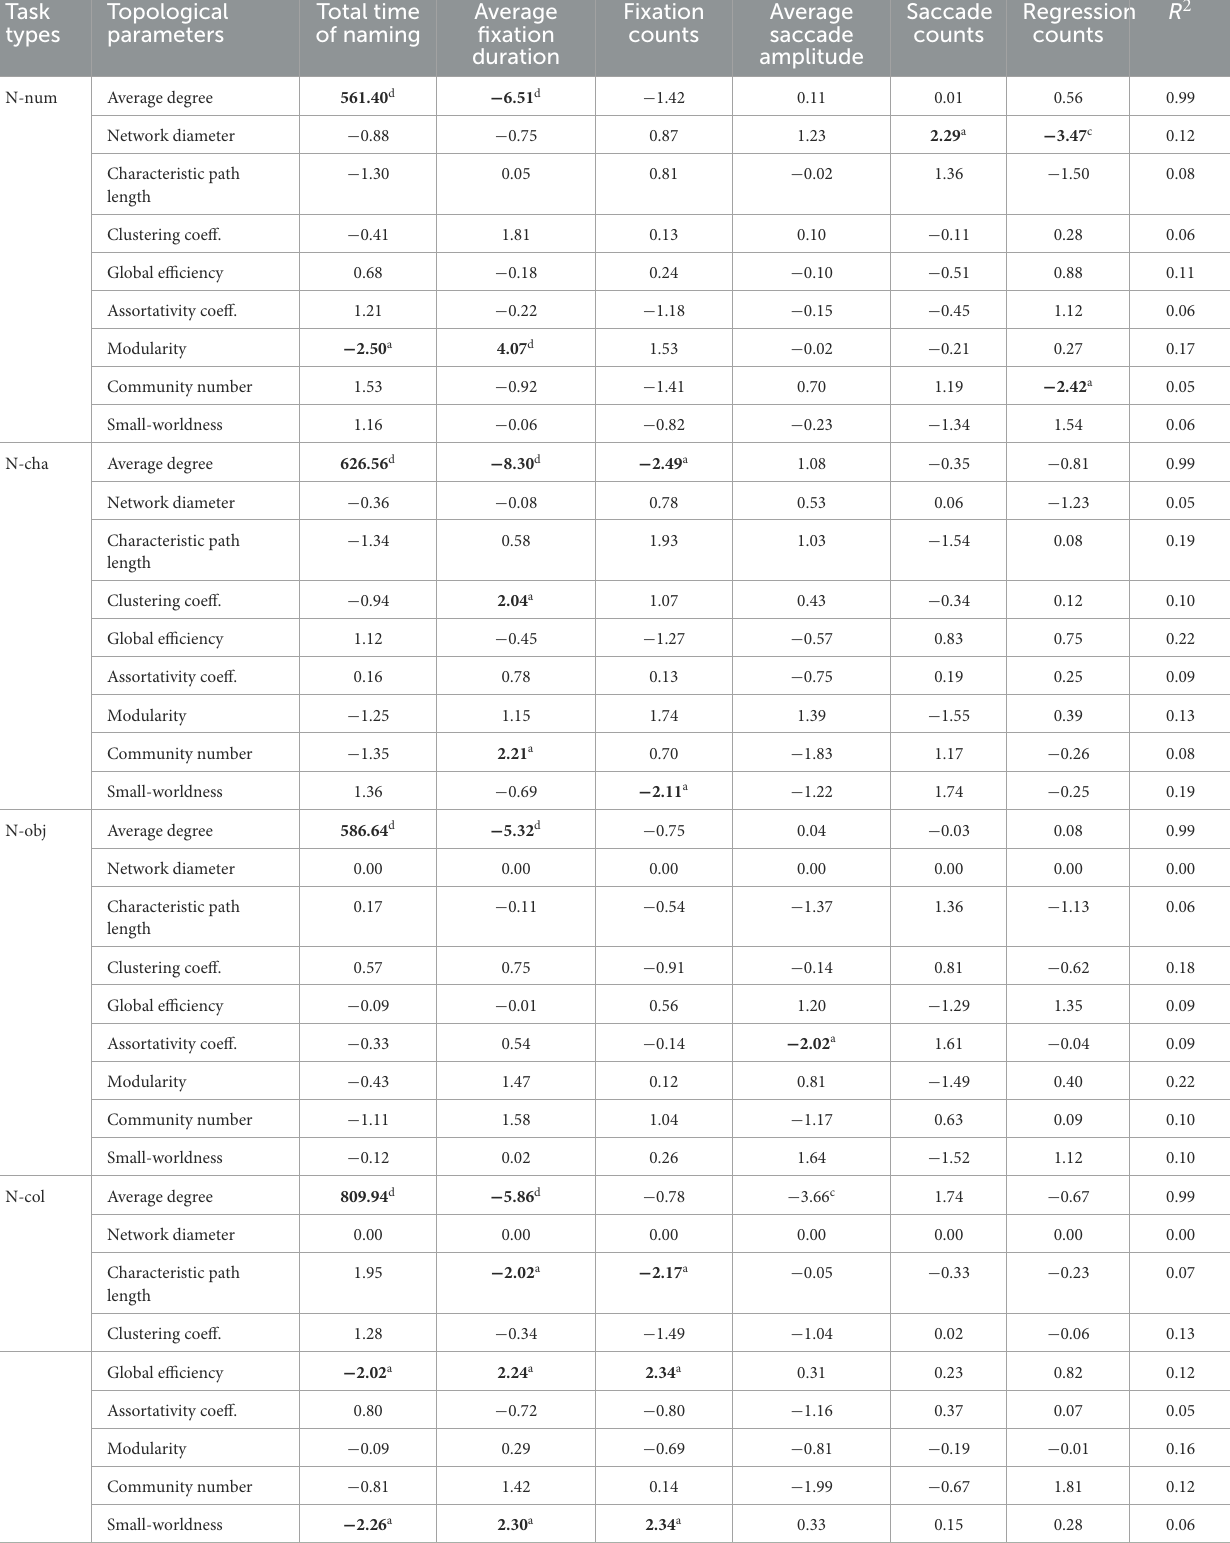
TABLE 2 The values t corresponding to the independent variables in the regression model for each of the nine topological parameters, with determination coefficient R 2 . Task